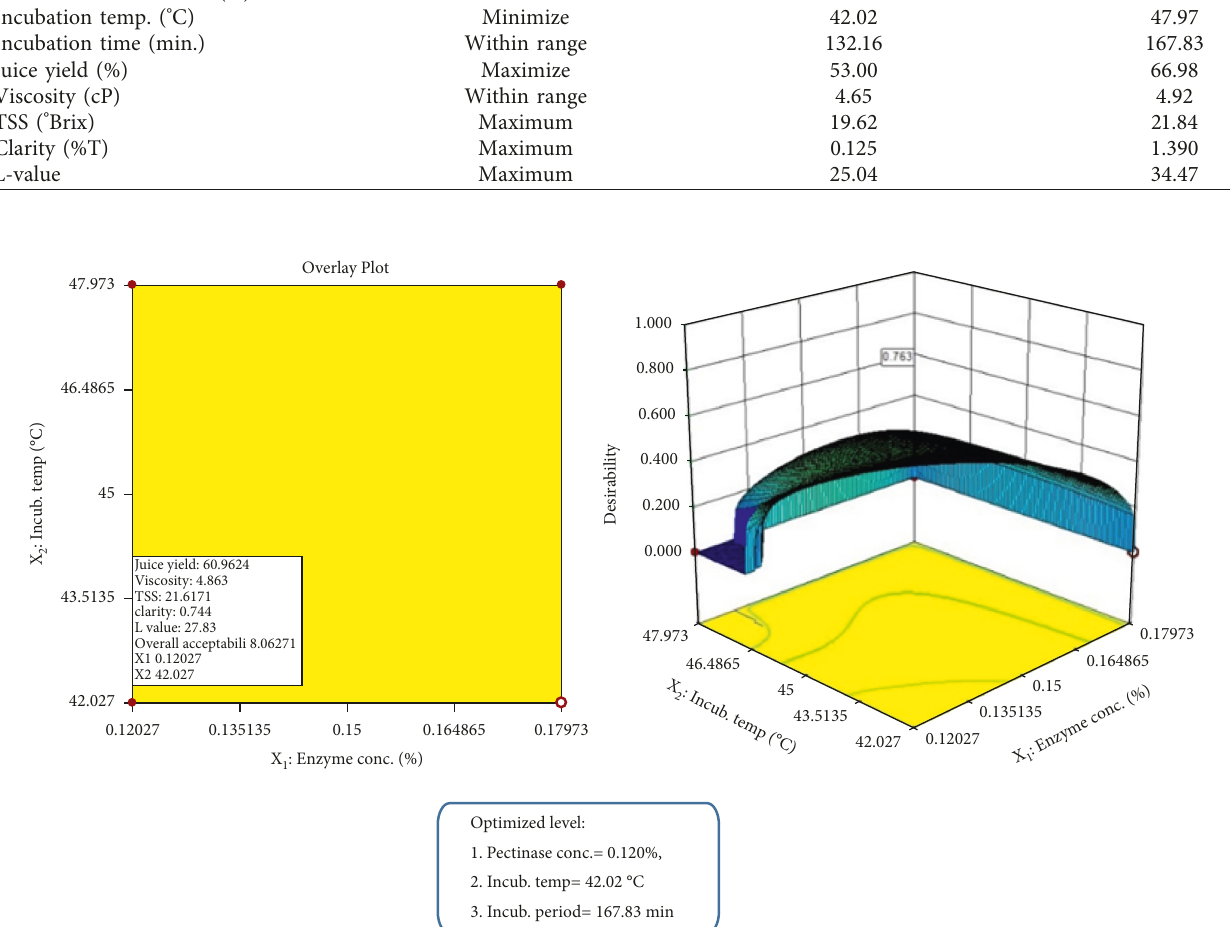
Figure 7: Overlay plot and desirability graph for optimum processing conditions as function of optimized sapodilla juice production.